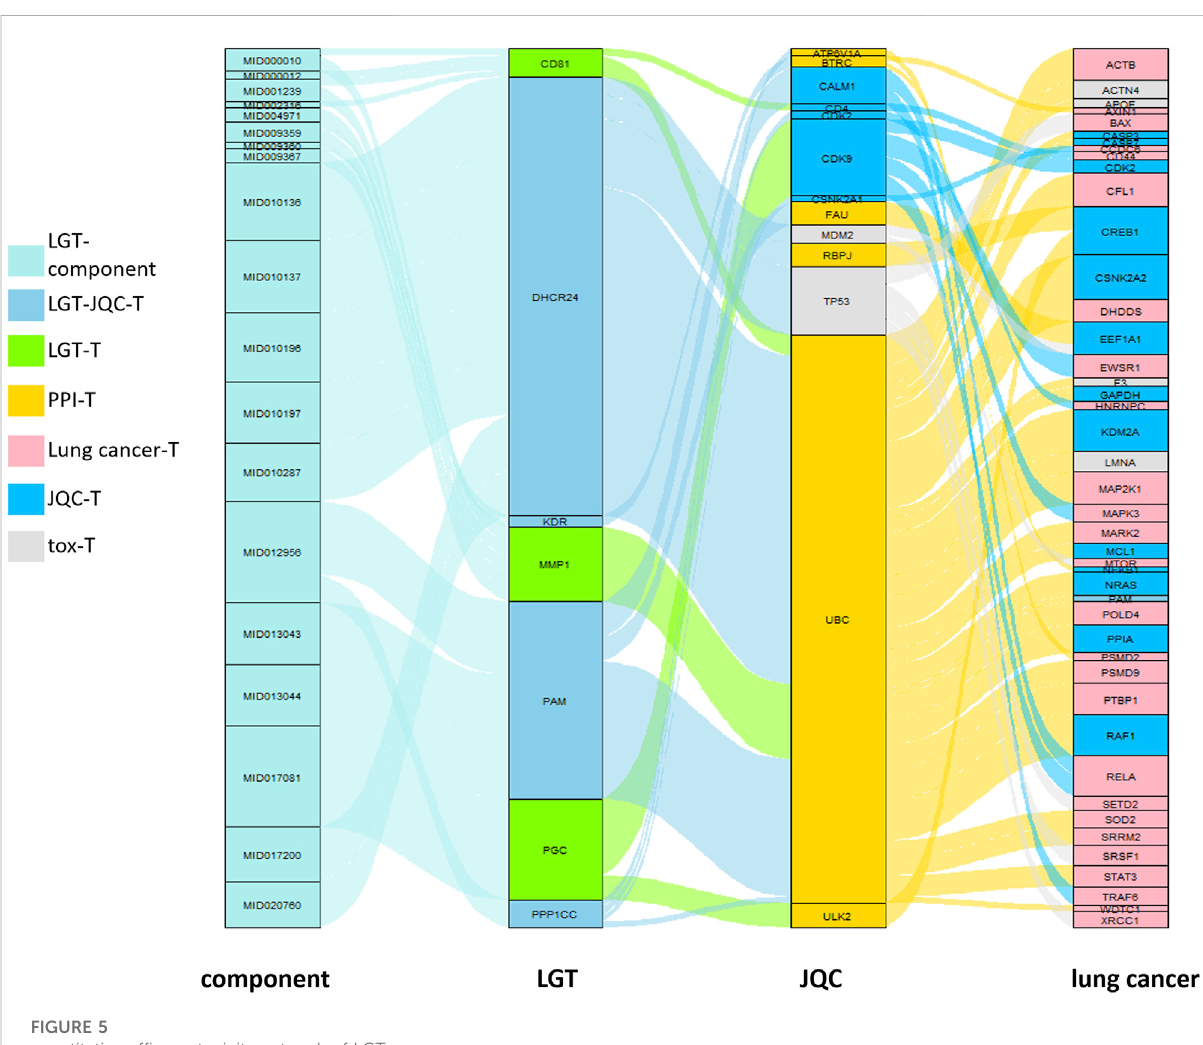
FIGURE 5 quantitative ef fi cacy-toxicity network of